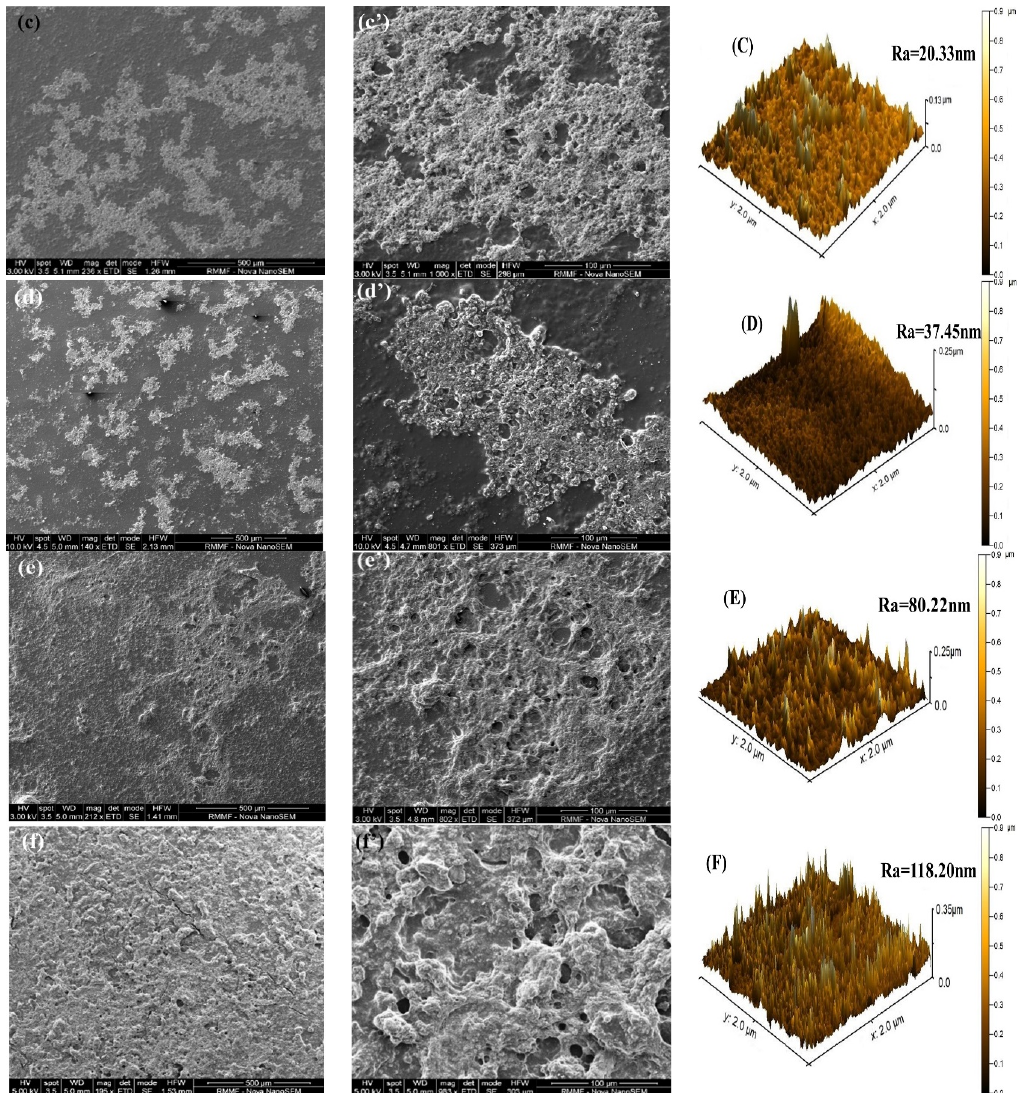
Figure 3. SEM images of the top surface of the TFC membranes at different magnification at different TiO 2 loading ( a and a’ ) = 0 wt.% TiO 2 ; ( b and b’ ) = 1 wt.% TiO 2 ; ( c and c’ ) = 1.5 wt.% TiO 2 ; ( d and d’ ) = 2 wt.% TiO 2 ; ( e and e’ ) = 3 wt.% TiO 2 ; ( f and f’ ) = 5 wt.% TiO 2 and AFM images of the corresponding membranes ( A ) = 0 wt.% TiO 2 ; ( B ) = 1 wt.% TiO 2 ; ( C ) = 1.5 wt.% TiO 2 ; ( D ) = 2 wt.% TiO 2 ; ( E ) = 3 wt.% TiO 2 and ( F ) = 5 wt.% TiO 2.